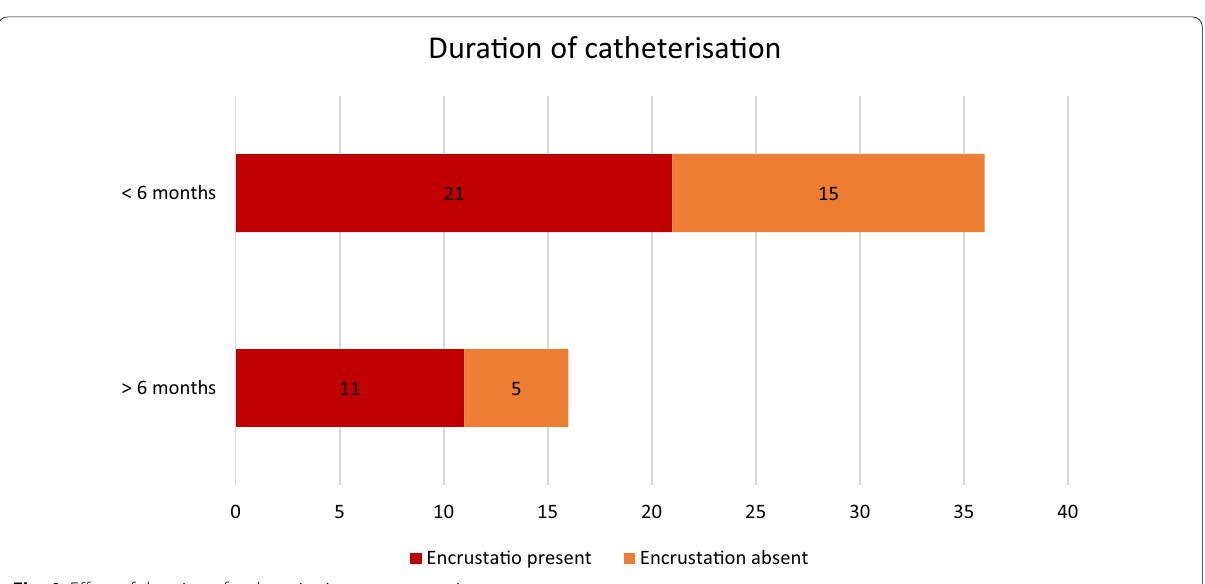
Fig. 4 Effect of duration of catheterisation on